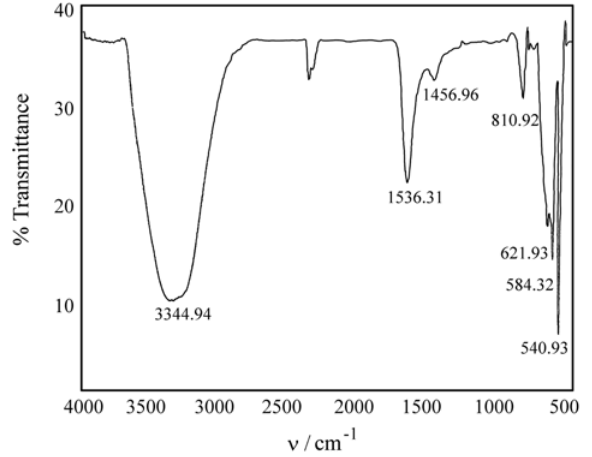
Figura 5b. Espectro IR característico de una disolución de 0.2 M de SnCl 2 , correspondiente a la muestra líquida obtenida del filtrado del sistema SnCl 2 -NH 4 OH-H 2 O a pH